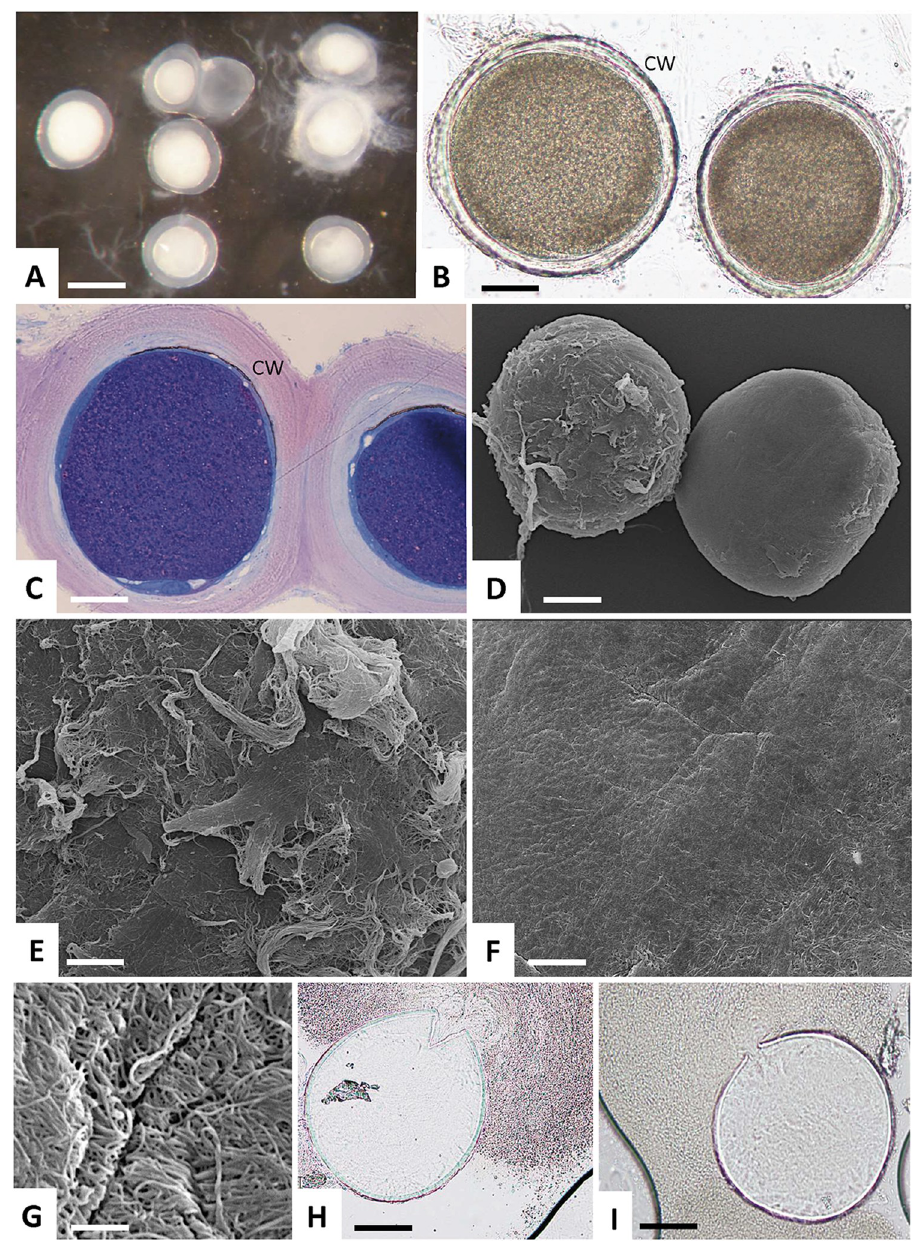
Fig 1. Microscopical description of isolated B . besnoiti tissue cysts. (A) Binocular view of cysts freshly isolated from skin. (B) Conventional light microscopy. CW = cyst wall. (C) Light microscopy of semi-thin sections of epoxy-resin embedded cysts stained with methylene blue and basic fuchsin. (D-G) Scanning transmission electron microscopy of the tissue cyst wall. (H, I) Ruptured cyst releasing bradyzoites and cyst matrix. Bars in A = 500 μ m, B = 140 μ m, C = 110 μ m, D = 170 μ m, E and F = 40 μ m, G = 1.6 μ m, H and I = 140 μ m.